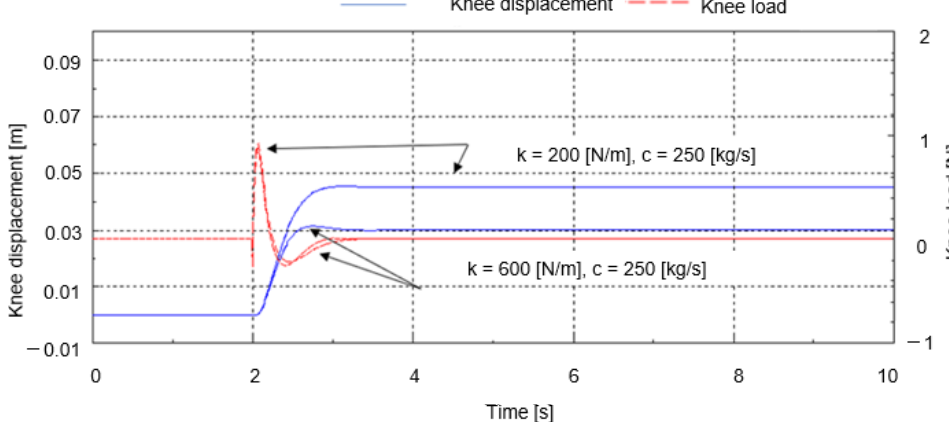
Figure 18. Comparison of device dumper constant.